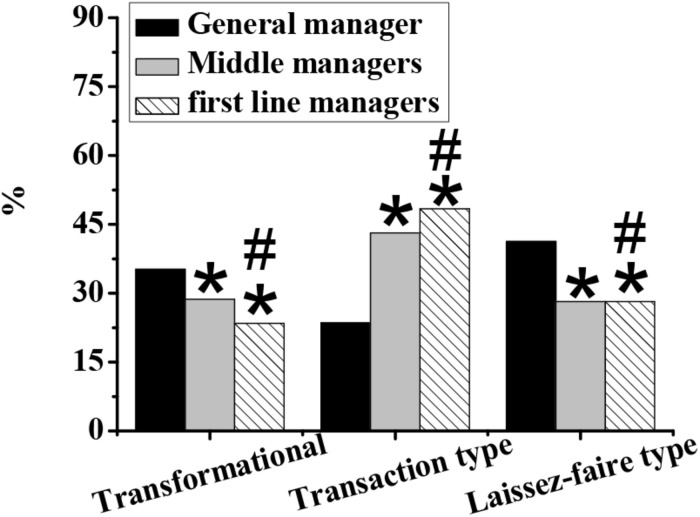
The differences of different entrepreneurial psychological leadership styles in positions. Note: An asterisk (*) indicates that the difference is statistically significant compared to general managers (p < 0.05); a number sign (#) indicates that the difference is statistically significant compared with middle managers (p < 0.05).